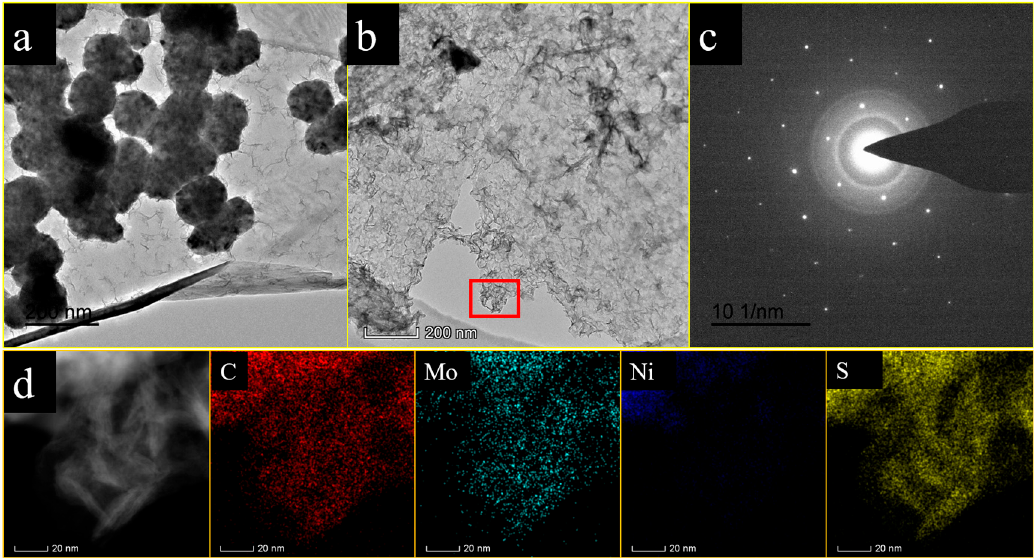
Figure 4. TEM images of ( a ) GNPs@Ni composite and ( b ) GNPs@Ni x S y @MoS 2 -3 composite. ( c ) Selected area electron diffraction (SAED) pattern of GNPs@Ni x S y @MoS 2 -3 composite. ( d ) Energy dispersive spectroscopy (EDS) elemental mappings of C, Mo, Ni, and S with corresponding TEM image of GNPs@Ni x S y @MoS 2 -3.